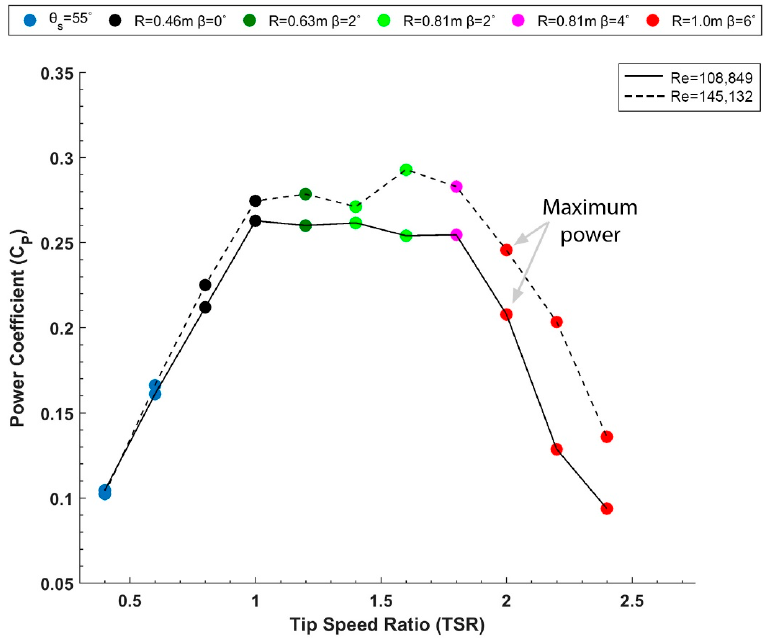
Figure 13. Overall power coefficient distribution of the optimized DR VAWT at Re = 108,849 and Re = 145,132.